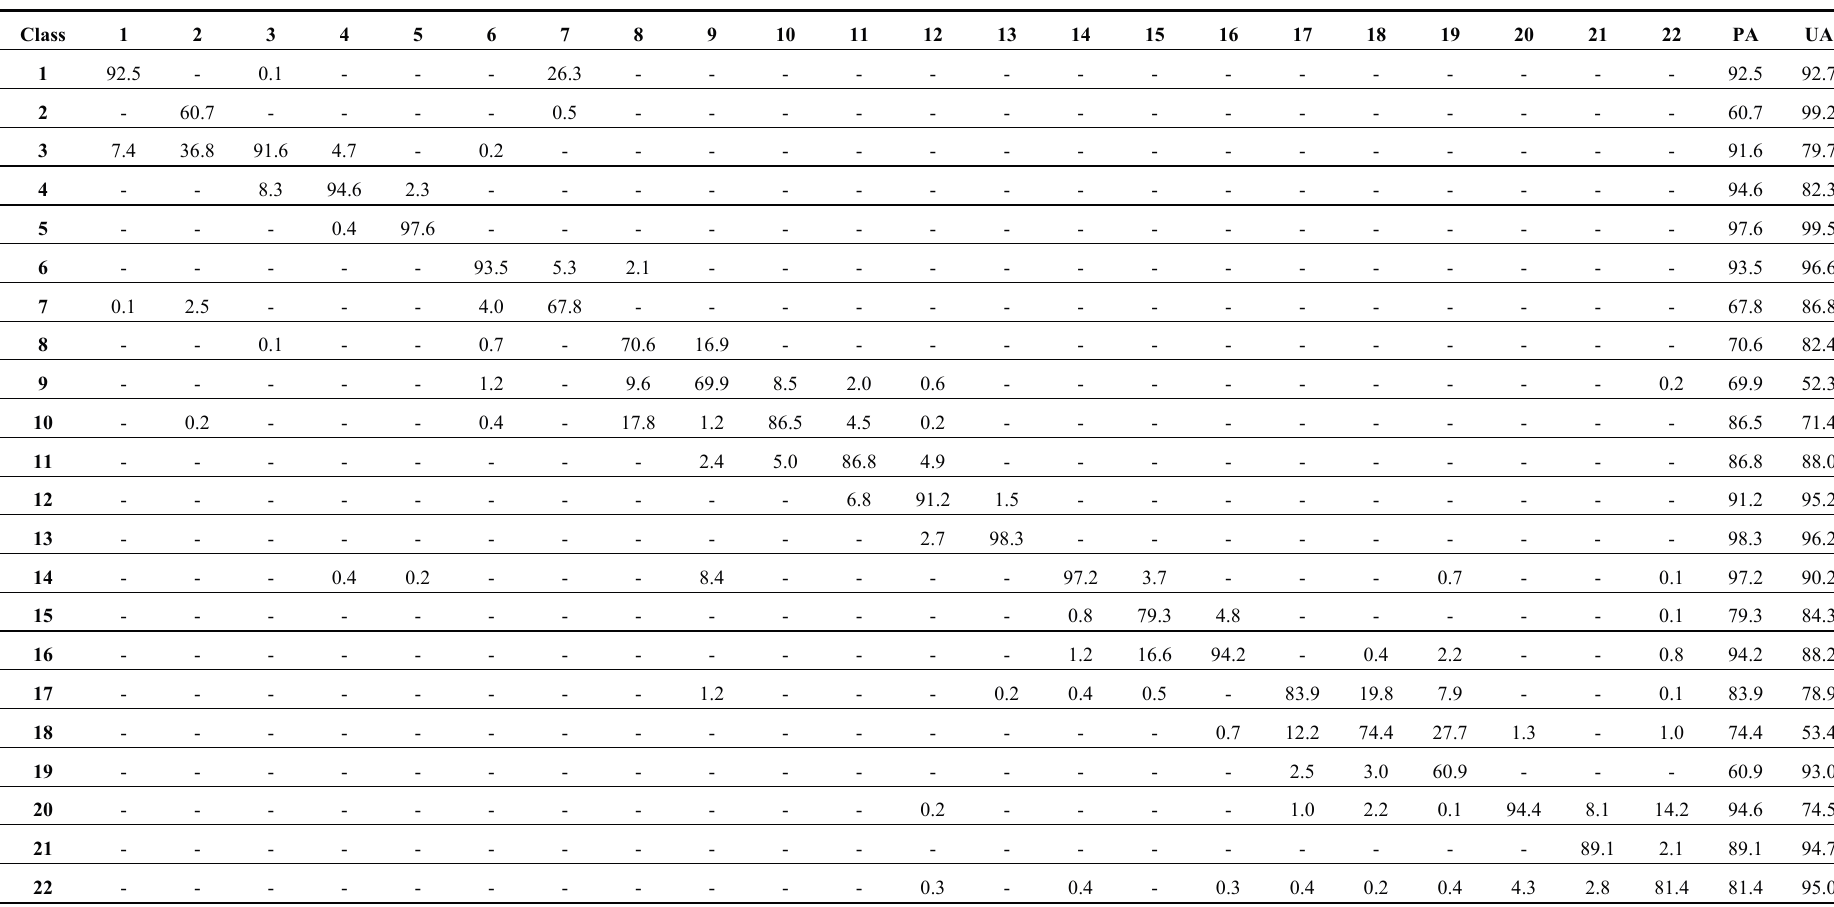
Table 1. Percent classification error for 22 classes of aquatic and wetland habitats at Level 5. Class numbers correspond with those in the legend of Figure